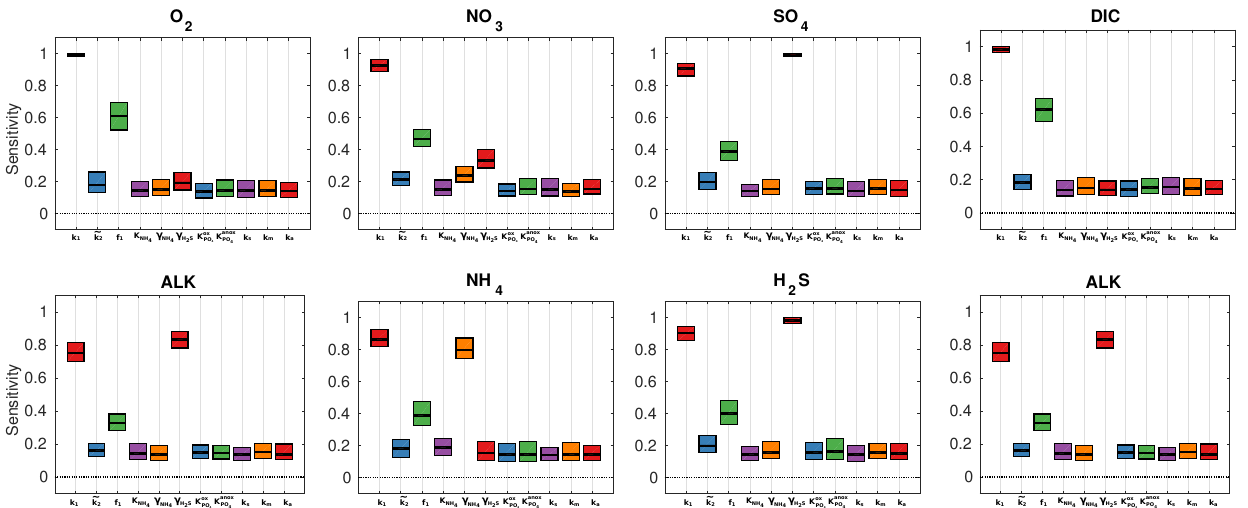
Figure B1. Box plot of parameter sensitivities for the calculated SWI fluxes for the 4000m oxic condition. Average sensitivities (black lines) and 90% confidence intervals using N = 11200 model evaluations and Nboot = 100 bootstrap resamples.